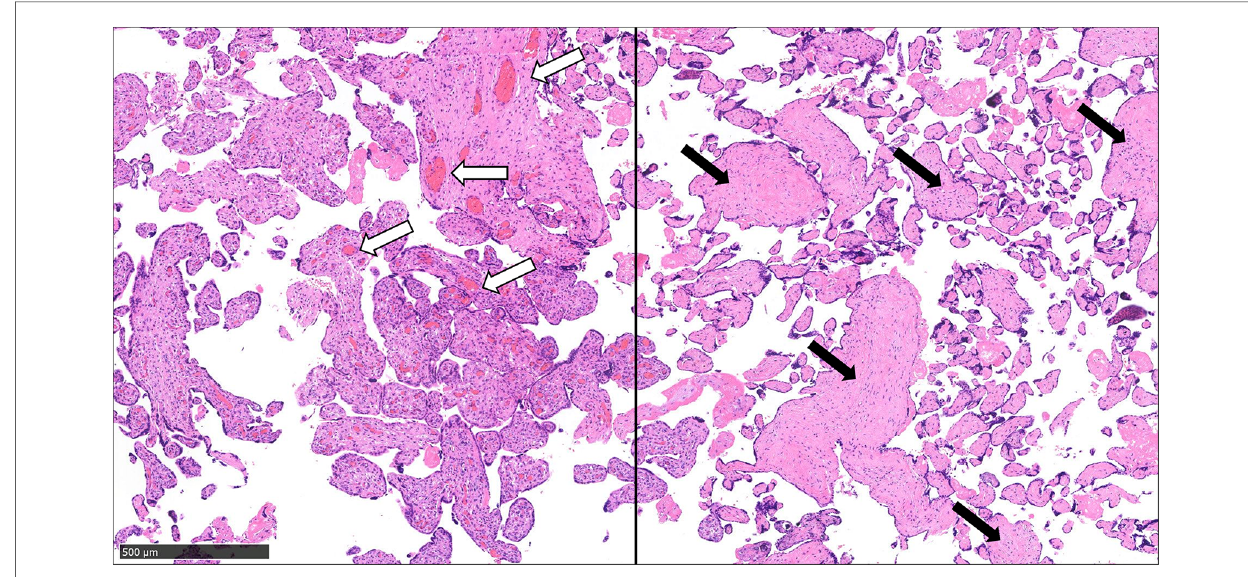
FIGURE 3 The pathological diagnosis of the placenta indicated fetal thrombotic vasculopathy. Pathological fi ndings of the placenta, in addition to normal capillaries (white arrows), thrombus formation in the umbilical artery, and reduction and collapse of villous interstitial capillaries in the periphery (black arrows) are observed (scale bar=500